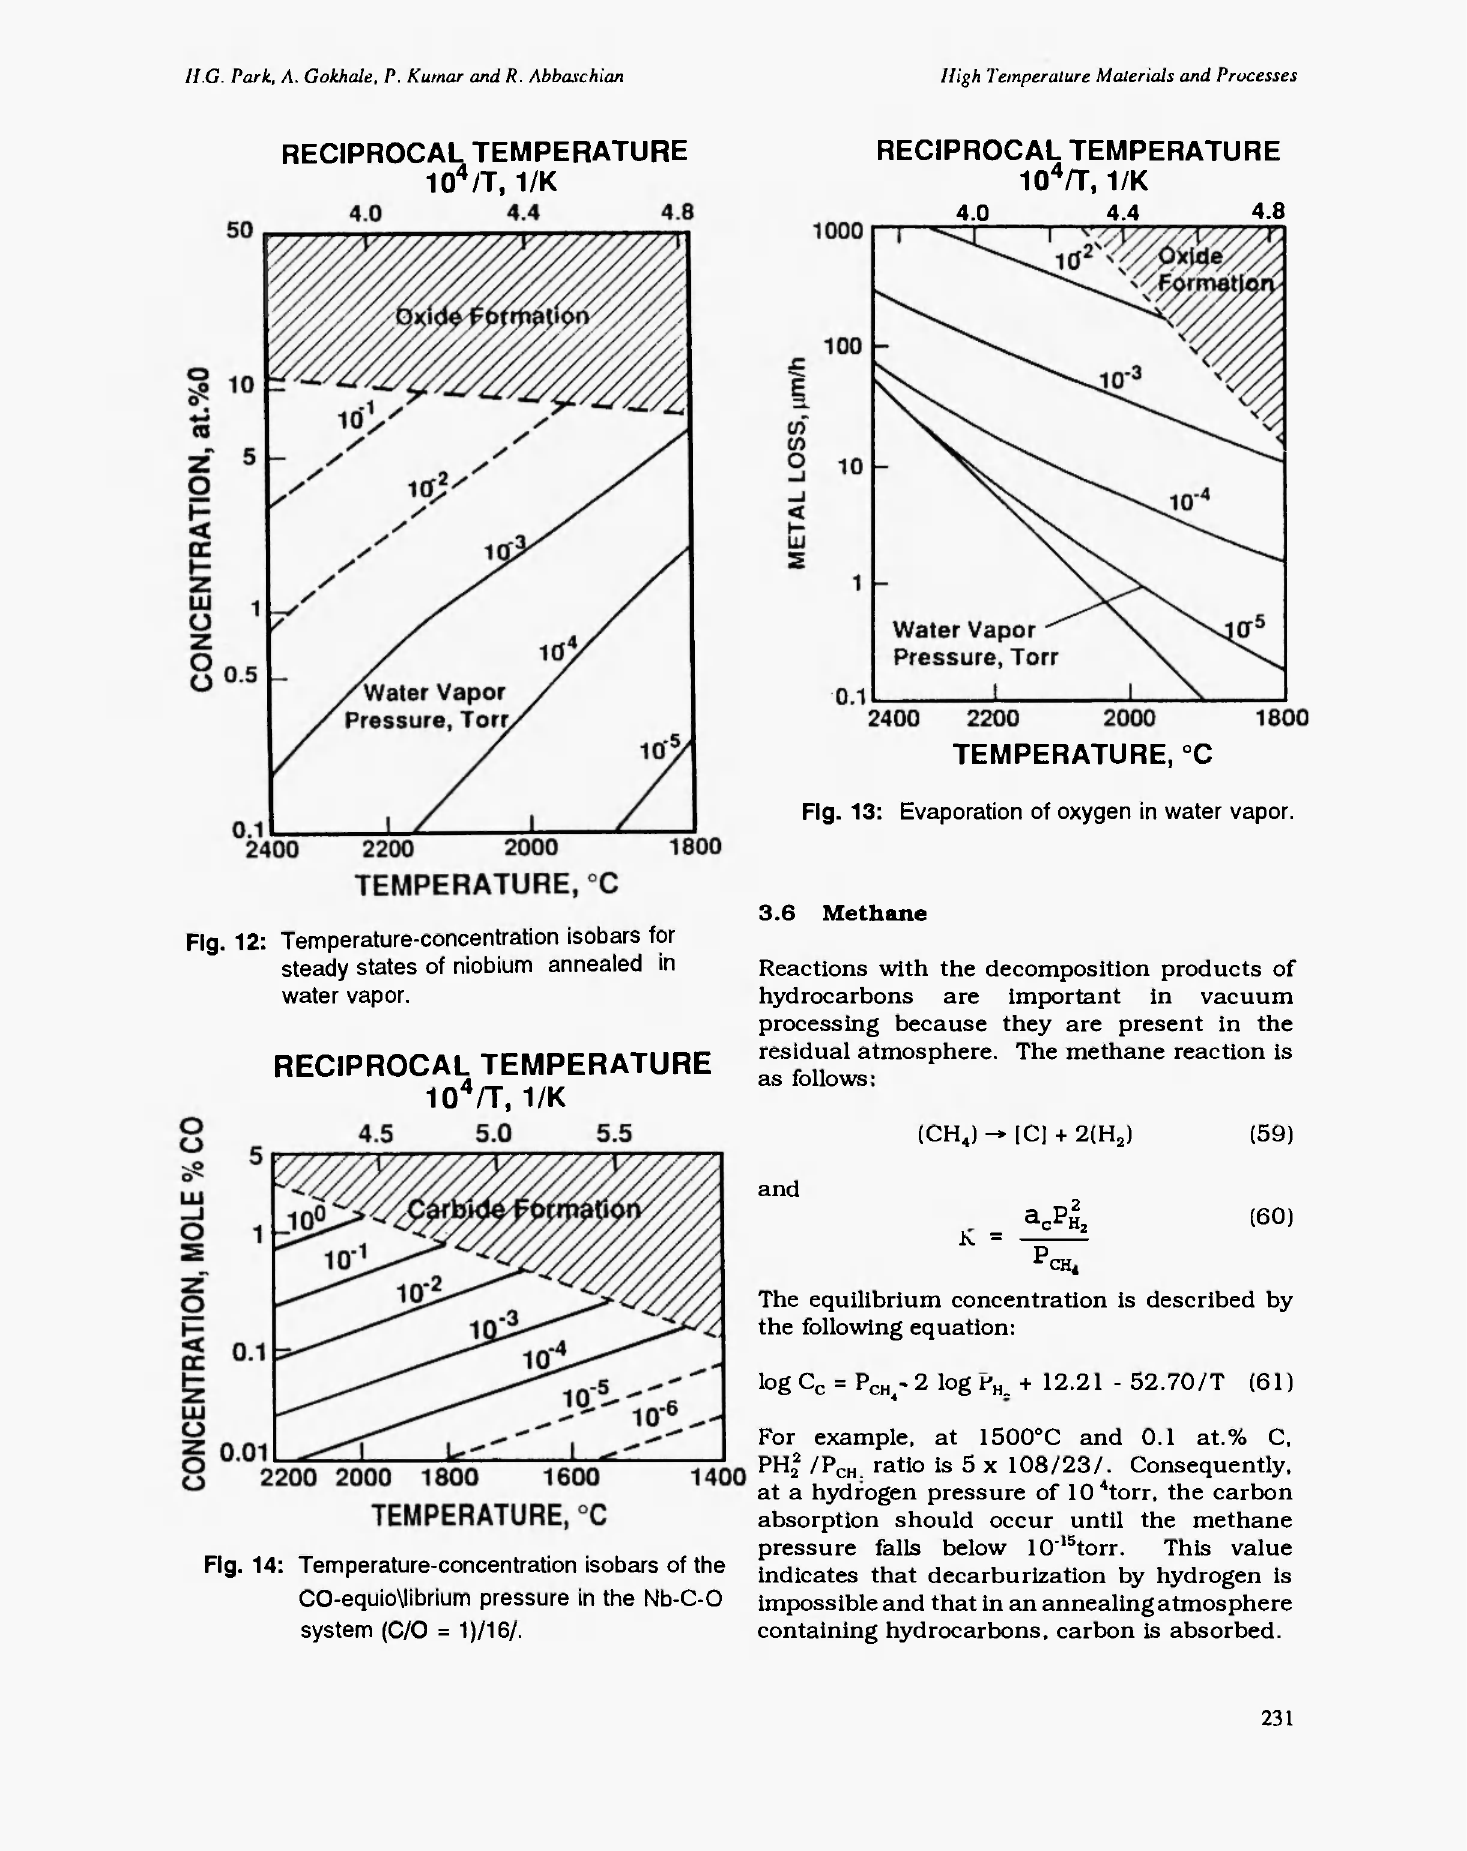
Fig. 14: Temperature-concentration isobars of the CO-equio\librium pressure in the Nb-C-0 system (C/O = 1 )/16/.